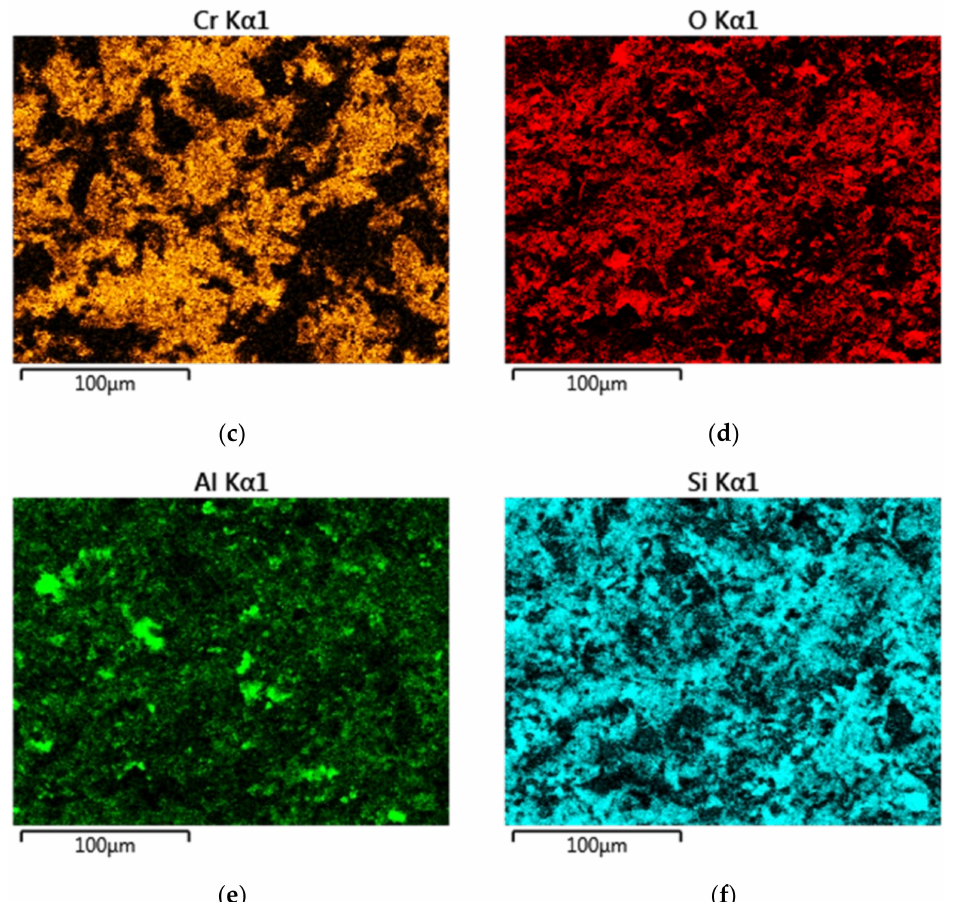
Figure 2. Microscopic image with the spatial distribution of elements in the fracture of S42 specimen (400 kPa/250 µ m); ( a ) topography view; ( b ) surface distribution of nickel; ( c ) surface distribution of chromium; ( d ) surface distribution of oxygen; ( e ) surface distribution of aluminum; ( f ) surface distribution of